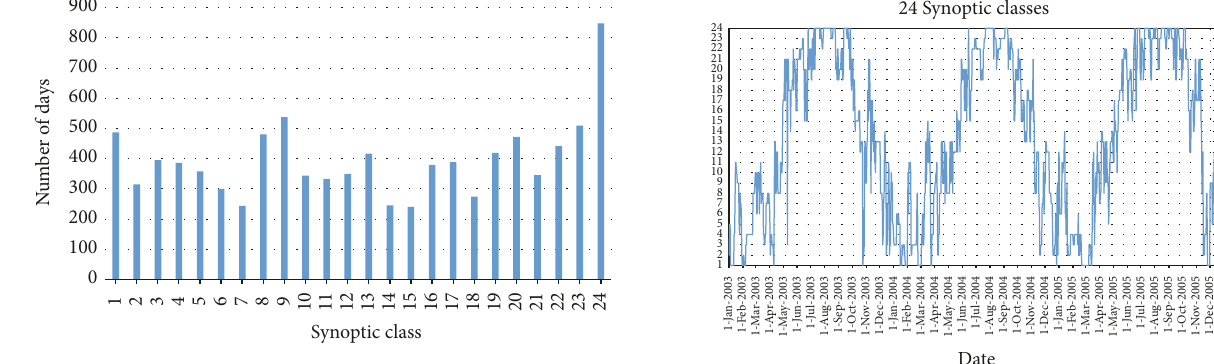
Figure 7: Frequency of appearance of the 24 synoptic classes in the 1980–2005 period. Figure 8: Daily synoptic classification with 24 synoptic classes in the period